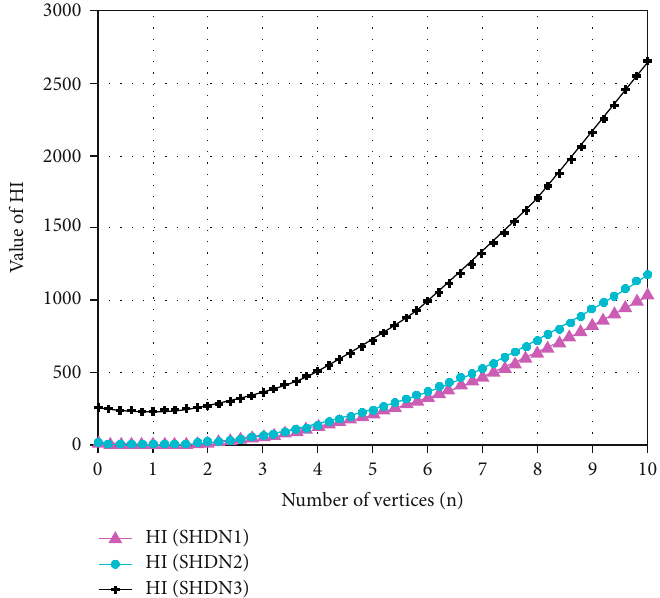
n Þ , Γ n Þ , and Γ n Þ using 2D graphs of HI. 1 ð 2 ð 3 ð